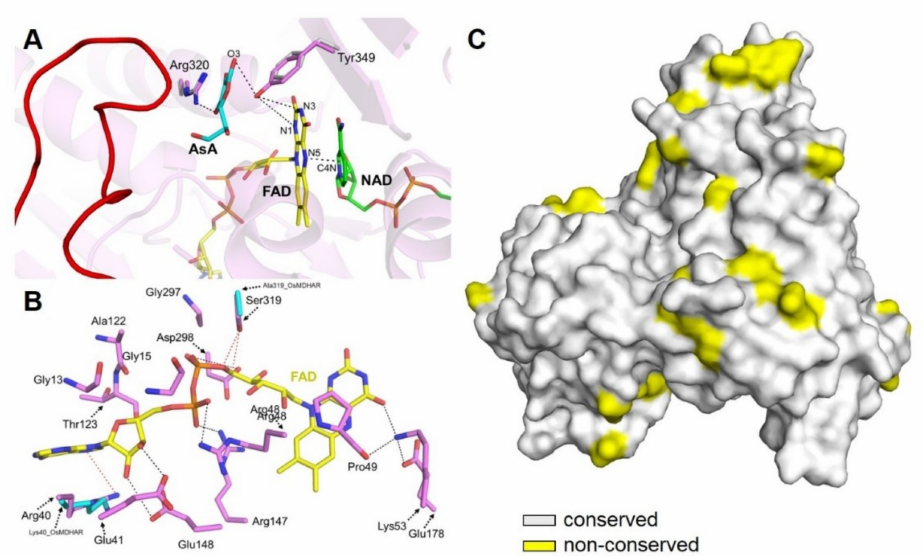
Figure 3. Structural comparison of DaMDHAR and OsMDHAR. ( A ) Close-up view of the electron transfer pathway from NAD to ascorbic acid (AsA) via FAD by the flanking Tyr349 on the superimposed structure of both proteins. ( B ) Close-up view of the FAD binding site. The residues that participate in hydrogen bonding and van der Waals interactions are shown as stick models and are colored green and blue, respectively. The bound FAD is colored yellow. ( C ) The superimposed structure of DaMDHAR and OsMDHAR showed that the amino acids on the surface of both proteins were highly